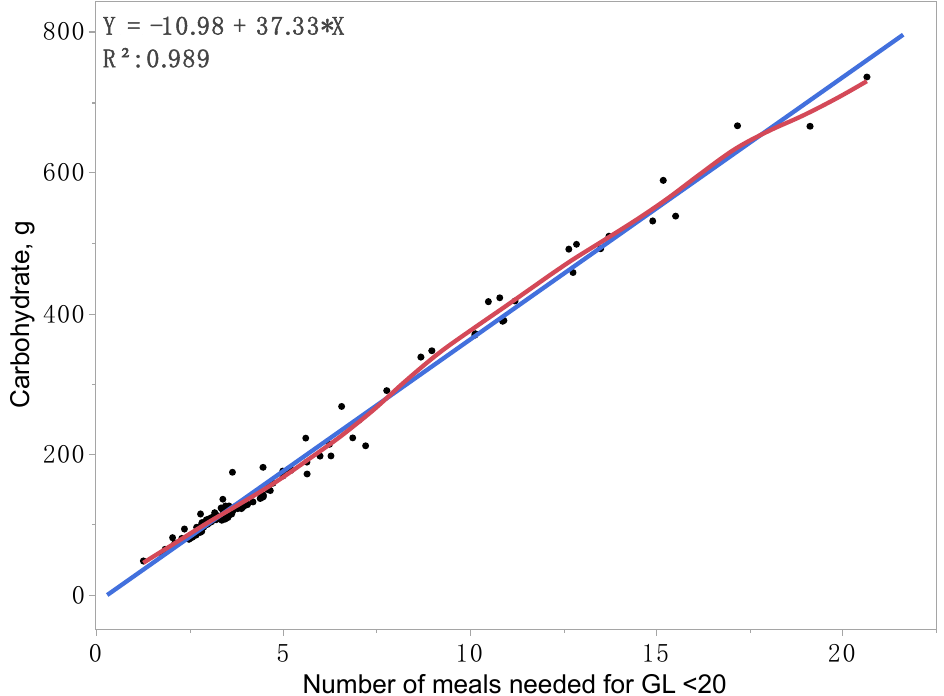
Figure 1. Prediction for carbohydrates per number of meals needed for glycemic load (GL) < 20. Blue line: linear fit, red line: curve fit.